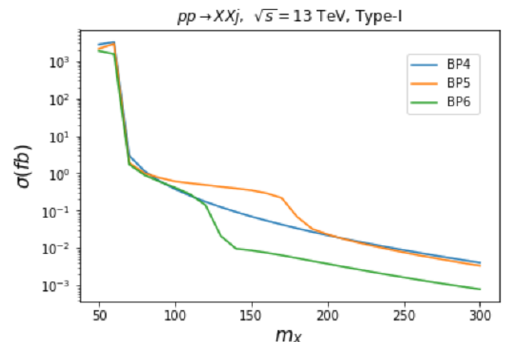
Table 2 . Benchmark points as drawn originally from the numerical scan which correspond to the curves of (cid:12)gure 5. We took the square root of the absolute value of active sector mass parameter m 12 so that a negative value corresponds to (cid:0) m 2 in the scalar potential. All mass parameters are 12 in GeV units.